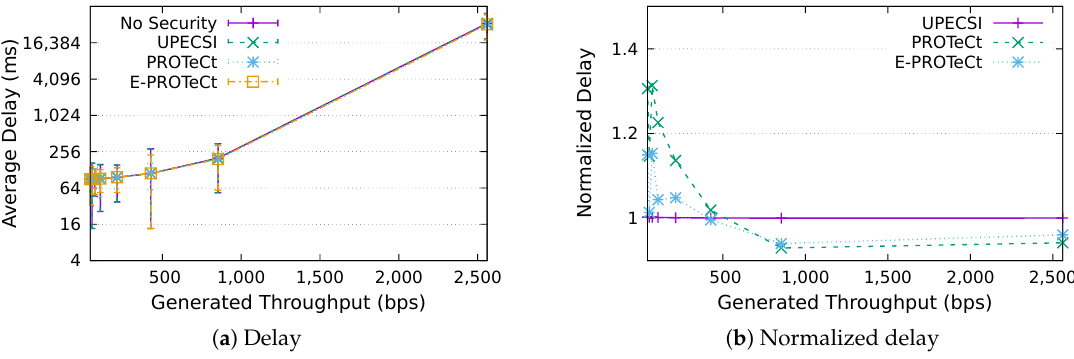
Figure 17. Delay analysis for an IoT network with 160